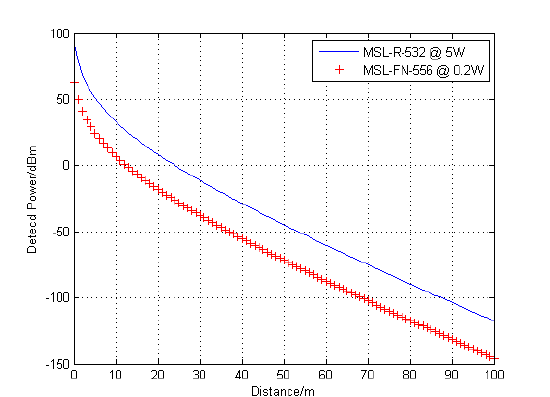
Figure 3. Detected power versus distance for MSL-R-532 and